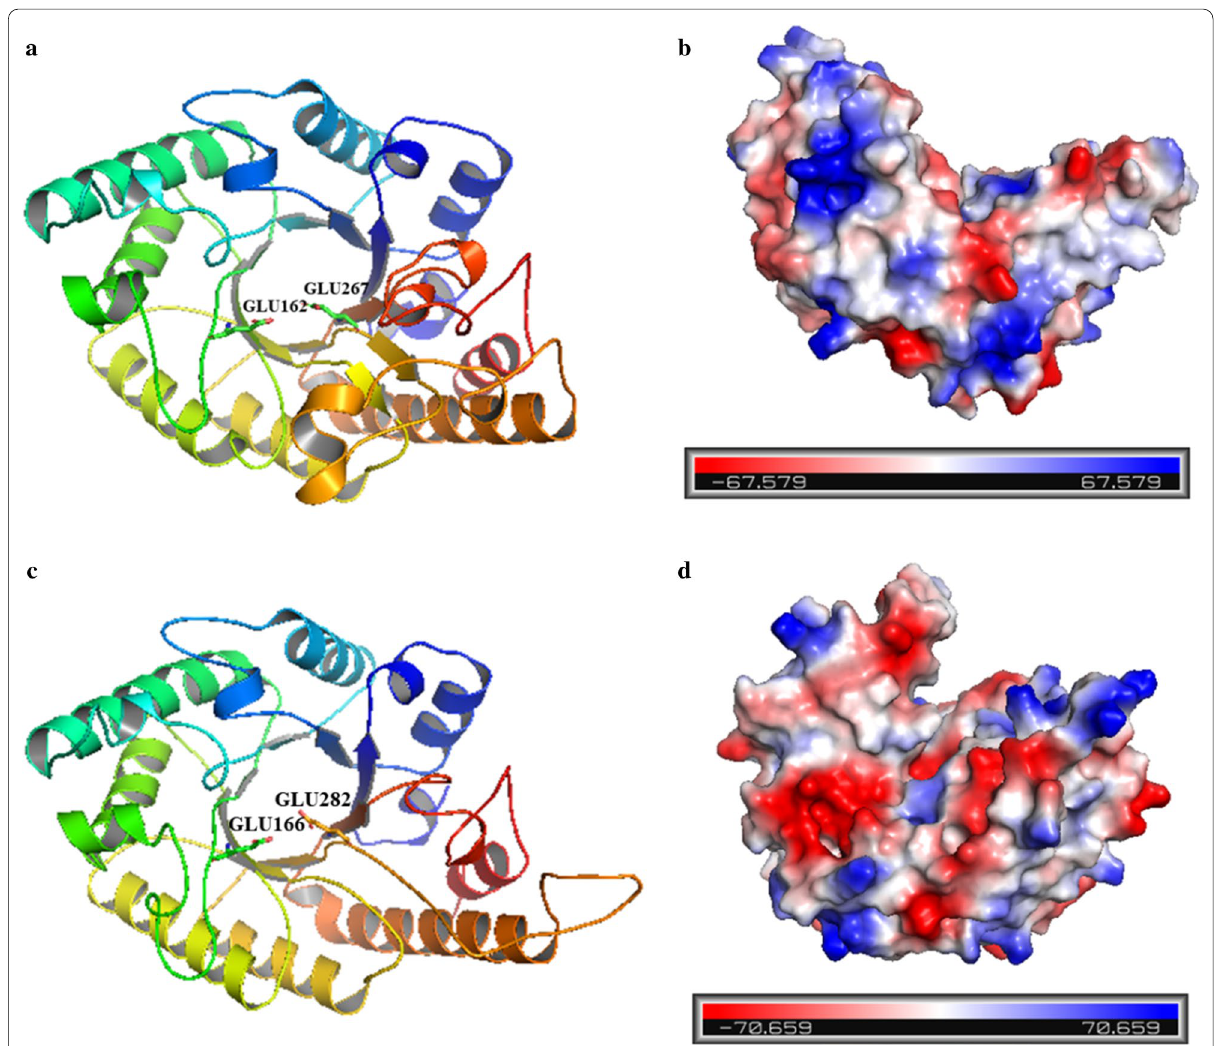
Fig. 3 3D model and electrostatic properties of PW-Xyl9 and PW-Xyl37. a 3D model of PW-Xyl9. GLU162 and GLU267 are the active sites of PW-Xyl9. b Electrostatic properties of PW-Xyl9. c 3D model of PW-Xyl37. GLU166 and GLU282 are the active sites of PW-Xyl37. d Electrostatic properties of PW-Xyl37. Enzyme electrostatic properties were predicted with PyMOL software. The red surface indicates that the relevant area has strong positive electrostatic properties, while the blue surface indicates the area has strong negative electrostatic